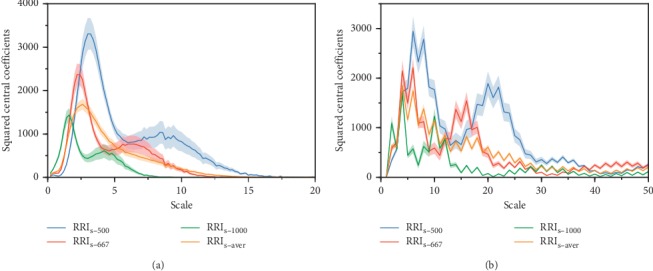
Squared central wavelet coefficients of PRSA curves at different scales for conventional DC and AC calculation. The shaded area represents the variation range of each curve. (a) Wavelet analysis using the third-order Gaussian wavelet. (b) Wavelet analysis using the Haar wavelet.